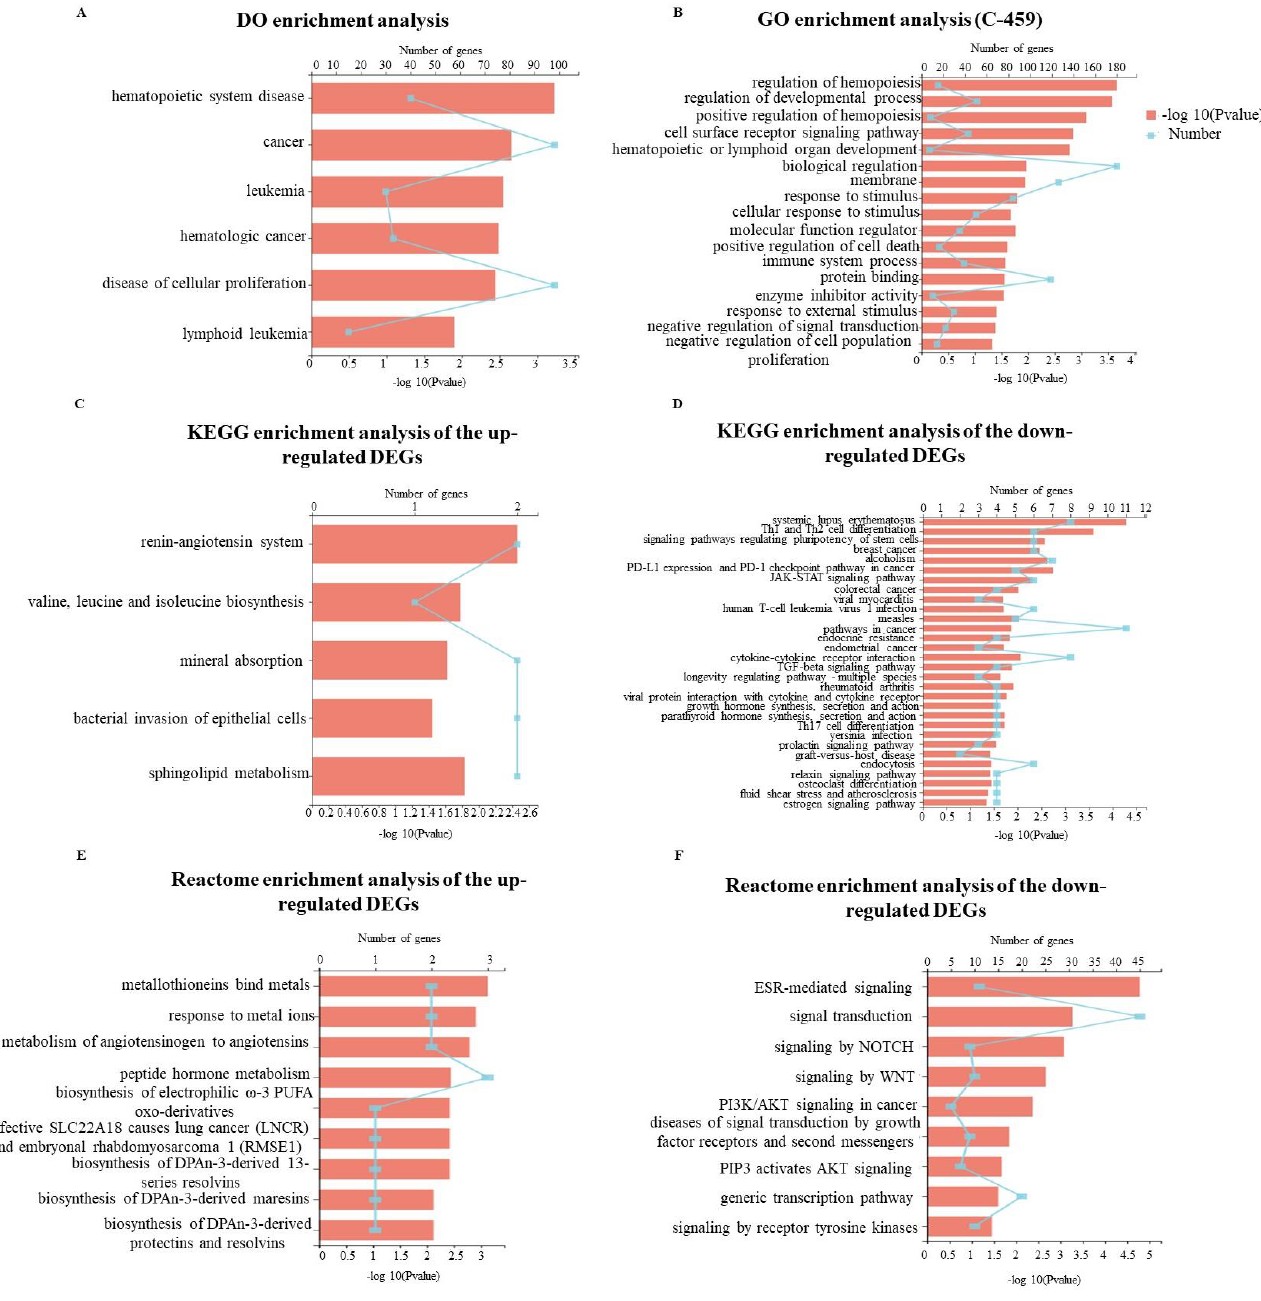
Figure 8. DO, GO, KEGG and Reactome enrichment analysis of DEGs induced by GD-NAIs. ( A ) DO enrichment analysis of DEGs. ( B ) GO enrichment analysis of DEGs. ( C ) KEGG enrichment analysis of the upregulated DEGs. ( D ) KEGG enrichment analysis of the downregulated DEGs. ( E ) Reactome enrichment analysis of the upregulated DEGs. ( F ) Reactome enrichment analysis of the downregulated DEGs.